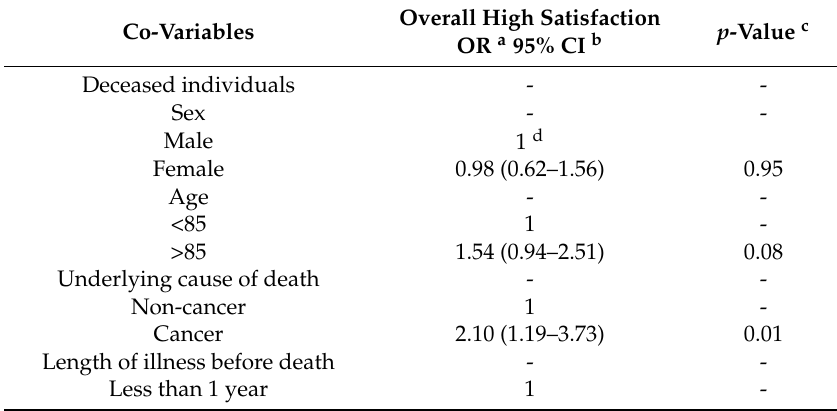
Table 2. Associations between the deceased individuals’ and bereaved family members’ characteristics, and the bereaved family members’ overall satisfaction with care during the last three months of life in all care